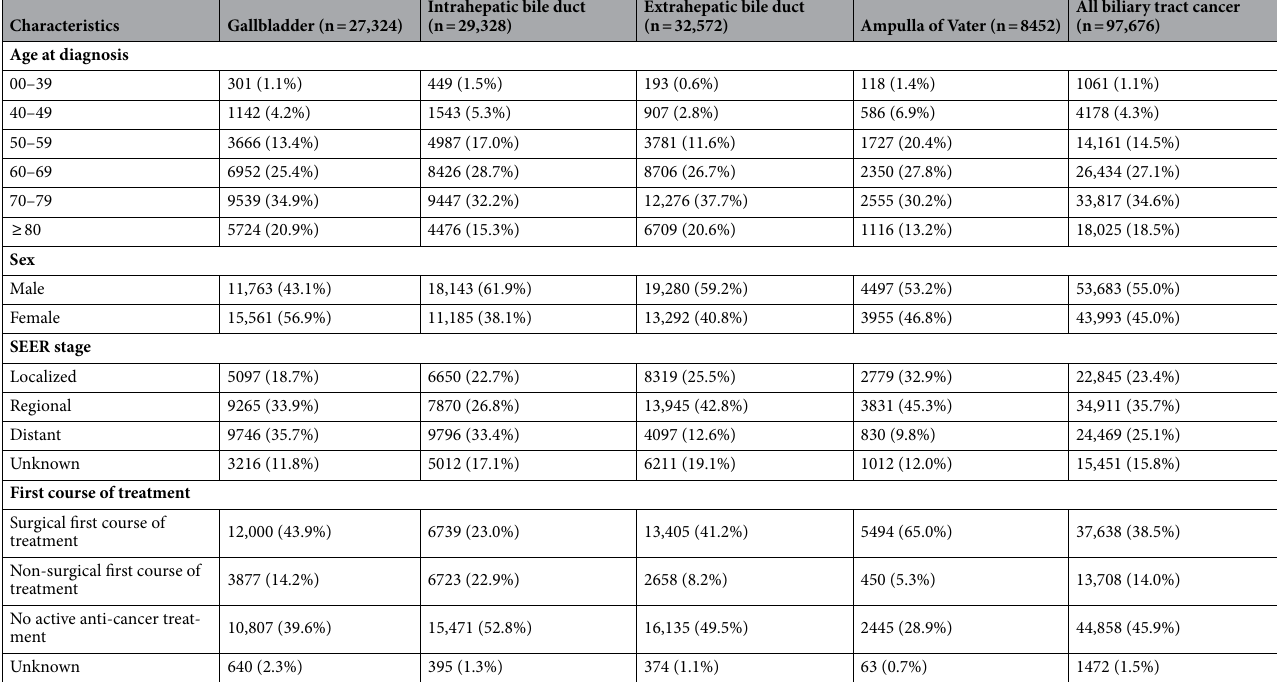
Table 1. Characteristics of patients with biliary tract cancer according to the tumor